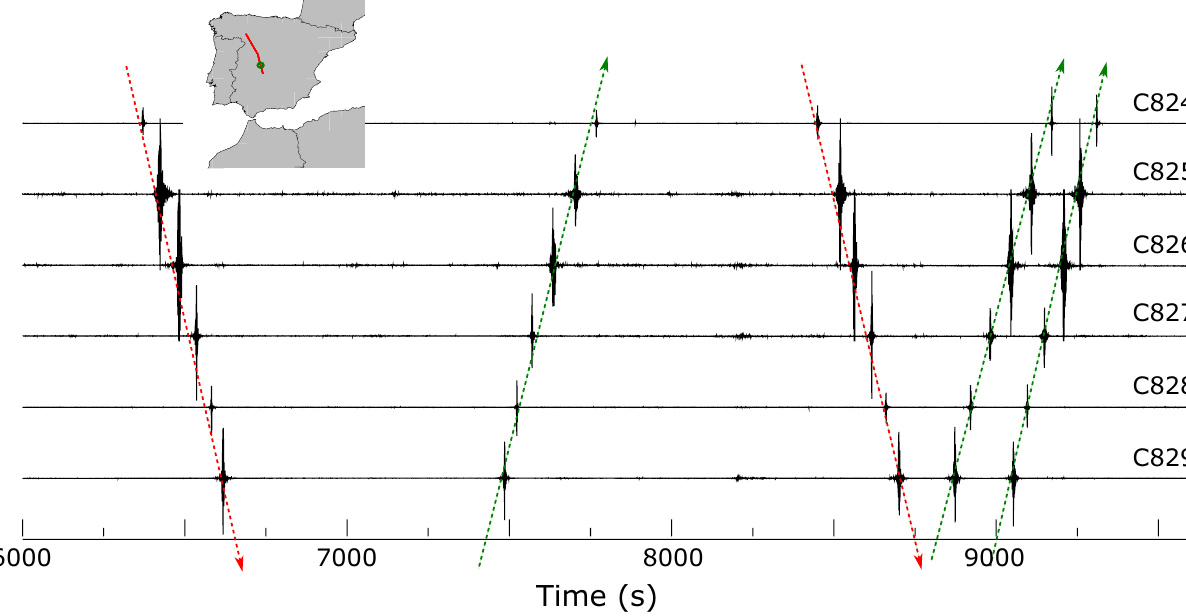
Figure 5. Seismic record of the waves generated by five vehicles moving along the seismic profile during a 40–50 min interval (traces C824-C829). Red lines mark vehicles moving southward and green lines those moving northward. The recording stations were installed along an unpaved road giving access to mountain areas and therefore, the low apparent velocities observed, ranging between 23 and 30 km/h seem